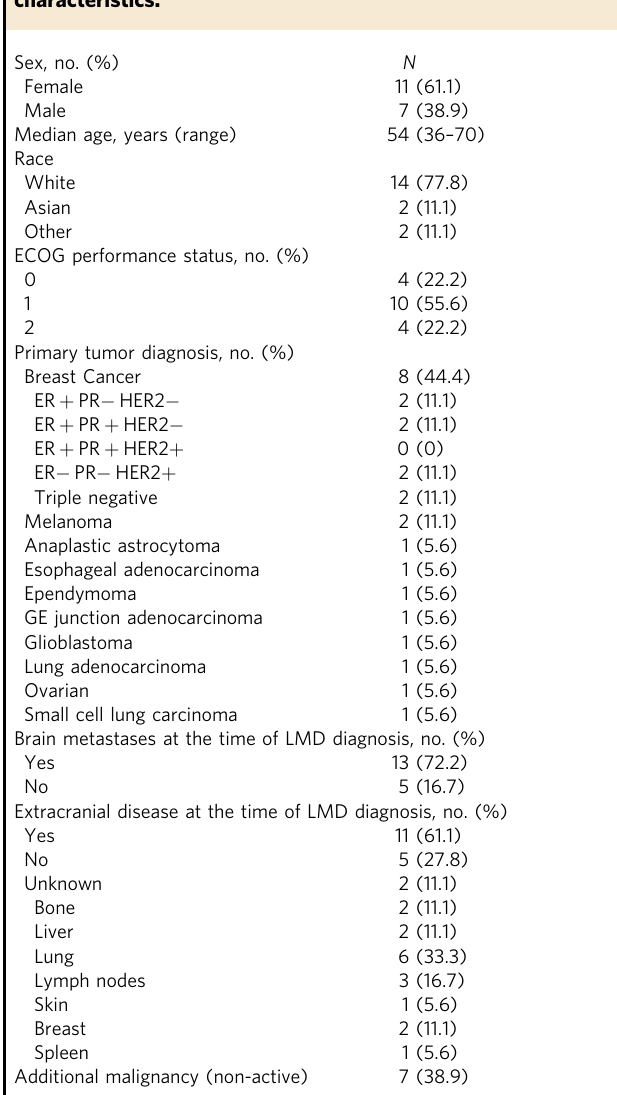
Table 1 Patient demographics and baseline disease